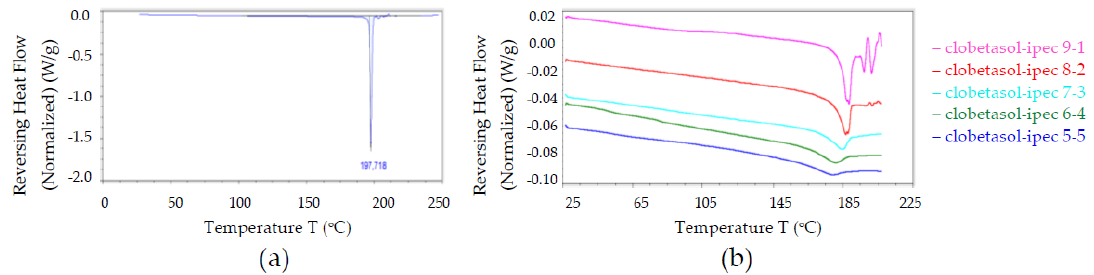
Figure 4. MDSC thermograms of ( a ) CP raw material and ( b ) CP loaded CP—in different ratios, namely 90:10, 80:20, 70:30, 60:40, and 50:50. 90:10, 80:20, 70:30, 60:40, and 50:50.